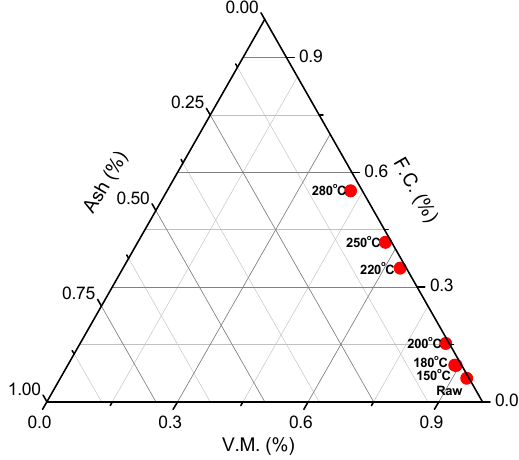
Figure 1. Change in cellulose properties caused by hydrothermal carbonization (F.C. is fixed carbon; V.M. is volatile matter).